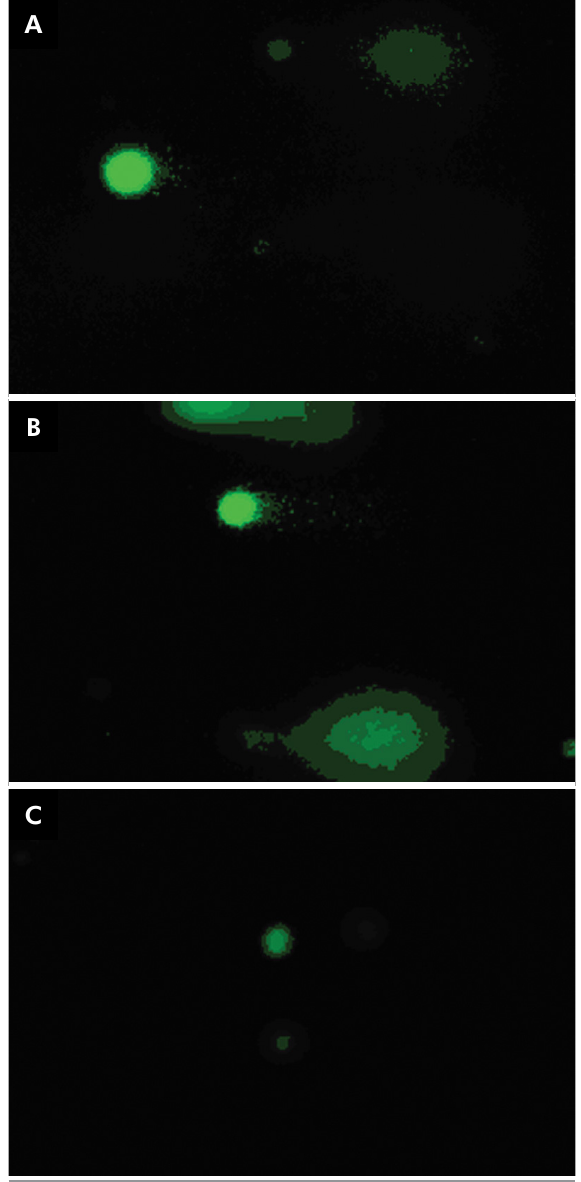
Figure 1. Levels of damage to bone marrow cells. (A) strand breaks (SBs) in Ca SiO -treated cells; (B) SBs in cyclophosphamide- 3 5 treated cells (positive control); (C) SBs in negative control cells.